Question: Express in one sentence what the figure is showing.
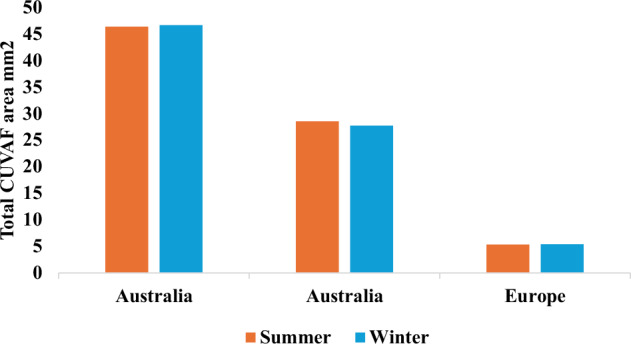
Answer: Weighted median conjunctival ultraviolet autofluorescence (CUVAF) area (mm²) of three studies [ 3 , 26 , 43 ] with measures during both summer and winter. There was no observed seasonal variation.